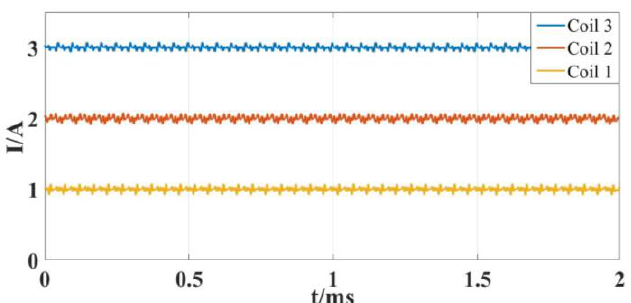
Figure 20. Coil currents driven by neutralized-sharing-bridge SPA.